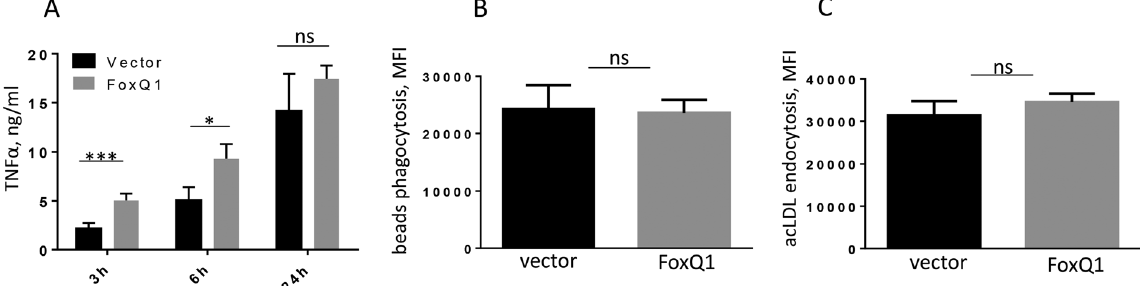
Figure 4. The analysis of inflammatory response and scavenging activity in FoxQ1 expressing RAW 264.7 cells. ( A ) FoxQ1 and empty vector-transfected cells were stimulated with LPS for 3 h, 6 h and 24 h, and TNF α production was analyzed by ELISA. The data are mean ± SD for two vector and two FoxQ1 clones analyzed in triplicates. * p < 0.05, *** p < 0.001; One-way ANOVA with Sidak’s multiple comparison test. ( B ) Phagocytosis of fluorescent latex beads in FoxQ1 and vector clones was performed for 3 h and assessed using flow cytometry. The data are mean fluorescence intensity (MFI) ± SD for 3 independent experiments with 3 FoxQ1 and 3 empty vector clones, ns - not significant, two-tailed Student’s t test. ( C ) Endocytosis of acLDL-Alexa488 was performed for 30 min and measured using flow cytometry. The data are MFI ± SD for 3 independent experiments with 3 FoxQ1 and 3 empty vector clones, ns - not significant, two-tailed Student’s t test.